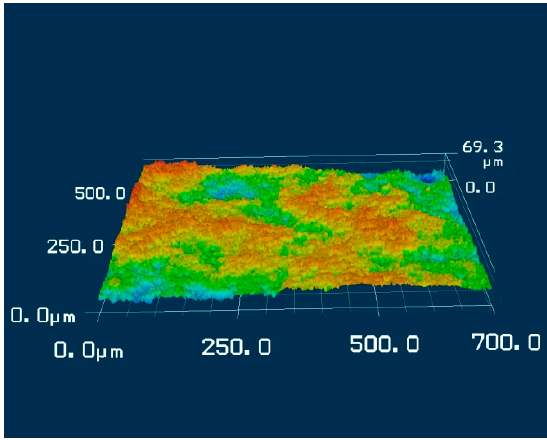
Figure 1. 3D profile of 90# calcined bauxite after the polishing process.